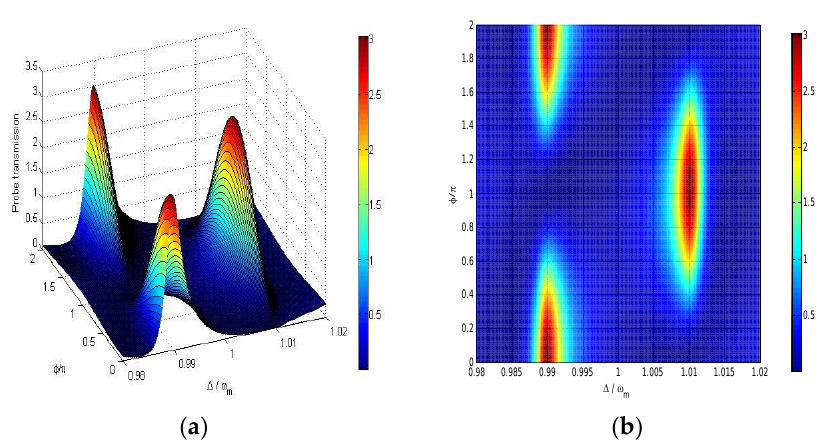
(cid:12) (cid:12) 2 versus (cid:12) t p (cid:12)